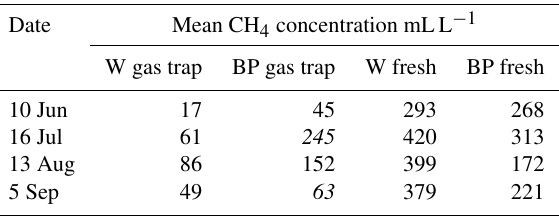
Table A1. Mean methane concentrations of the gas caught in the gas traps and of fresh ebullition samples in 2014. Concentration samples were collected four times from gas traps on water (W) and bare peat (BP) surfaces and by triggering fresh ebullition from similar surfaces.